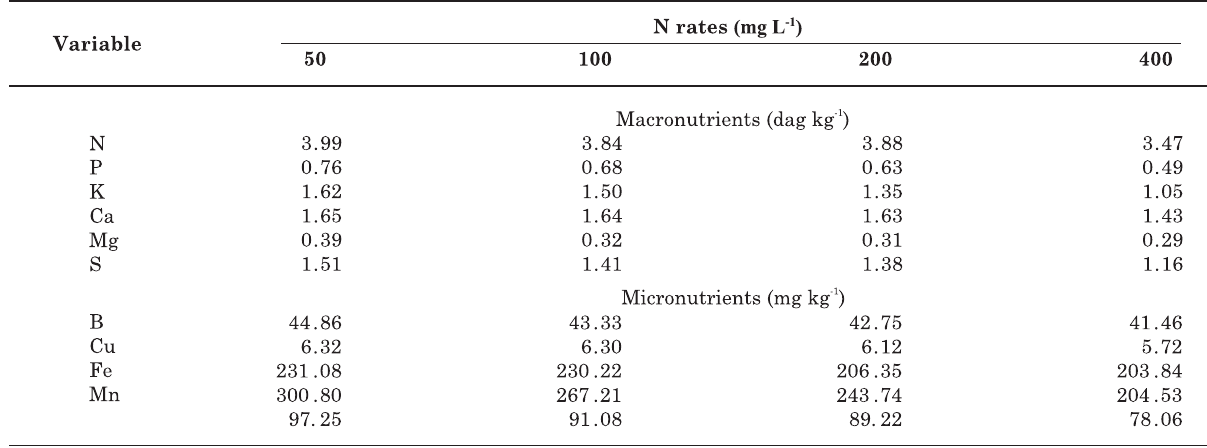
Table 1. Mean content of macro and micronutrients in DMMC/MS, as related to N rates in the nutrient